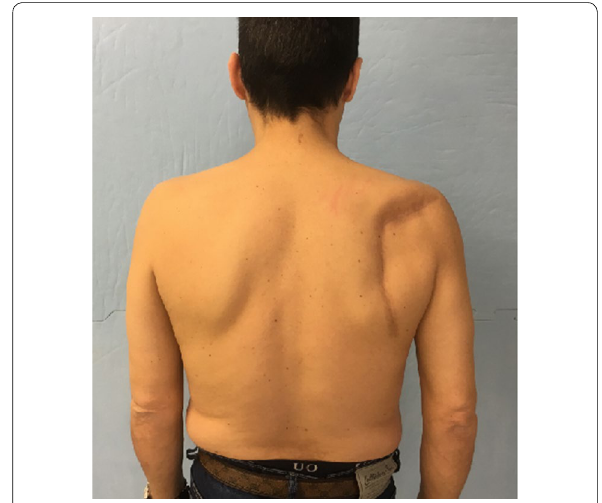
Fig. 3 Patient who underwent the classic Judet approach, with evident infraspinatus